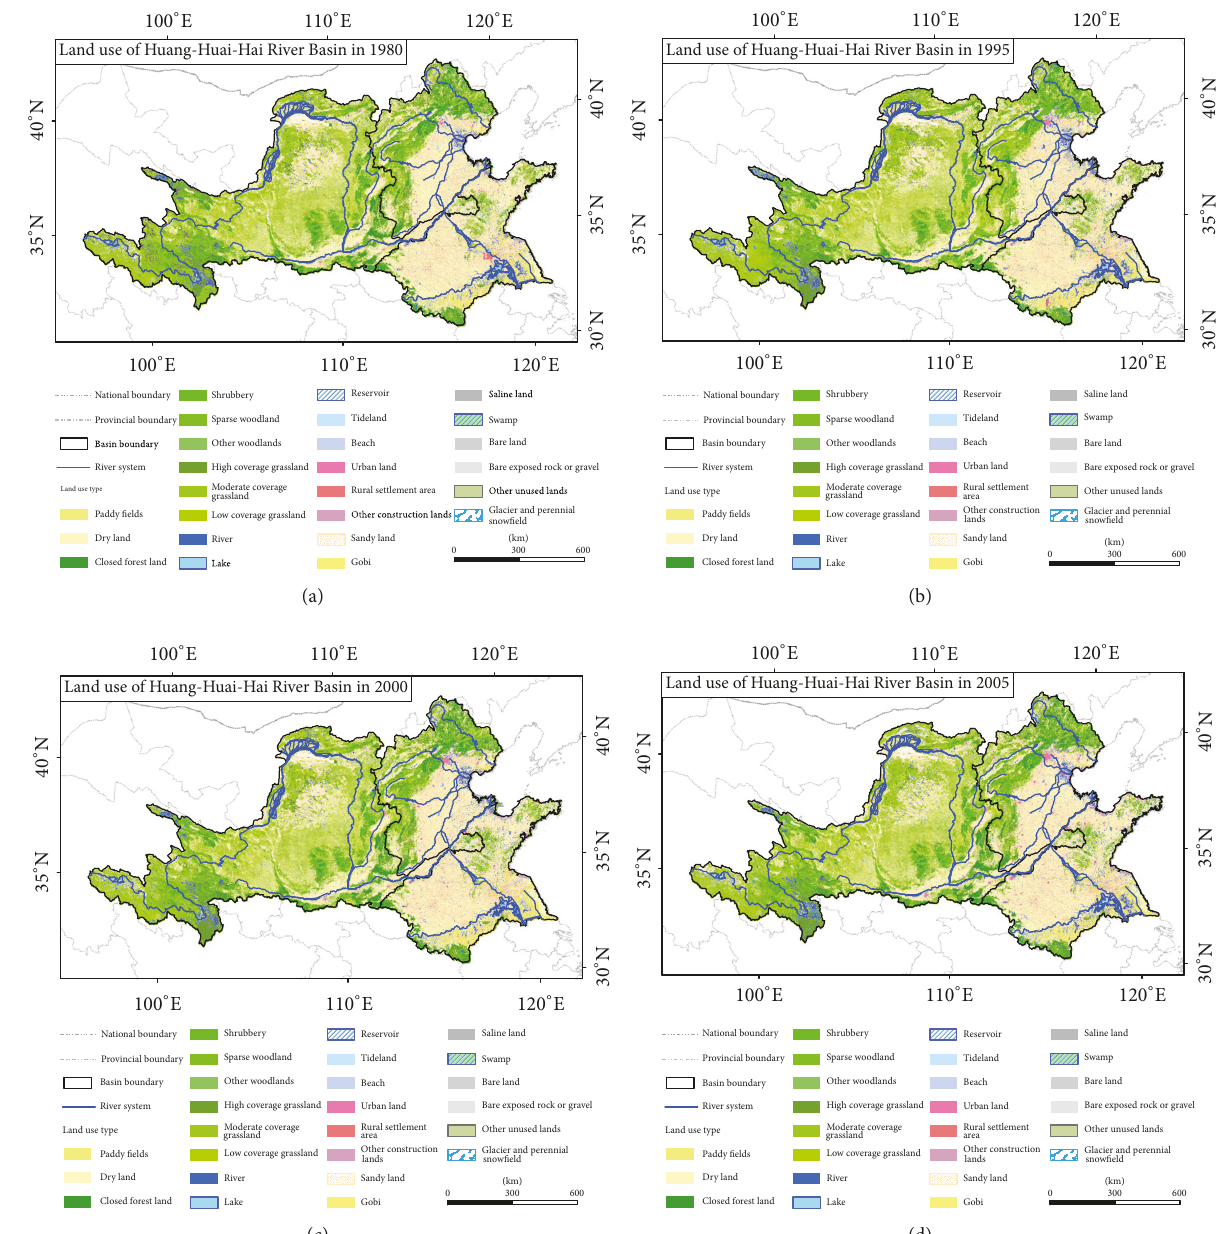
Figure 14: Land use/cover change in the Huang-Huai-Hai River Basin from 1980 to